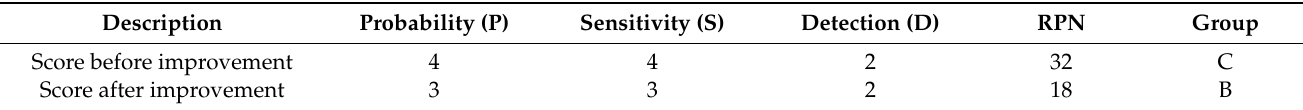
Table 10. Effects of improvement on damage occurrence and sensitivity following performance improvements of a specific